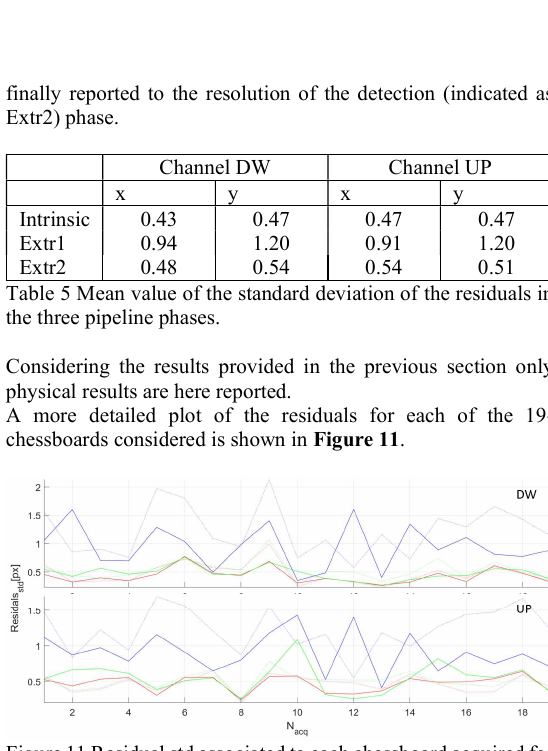
Figure 11 Residual std associated to each chessboard acquired for the (cid:2160)(cid:2179) and (cid:2177)(cid:2172) channels in the three phases of the